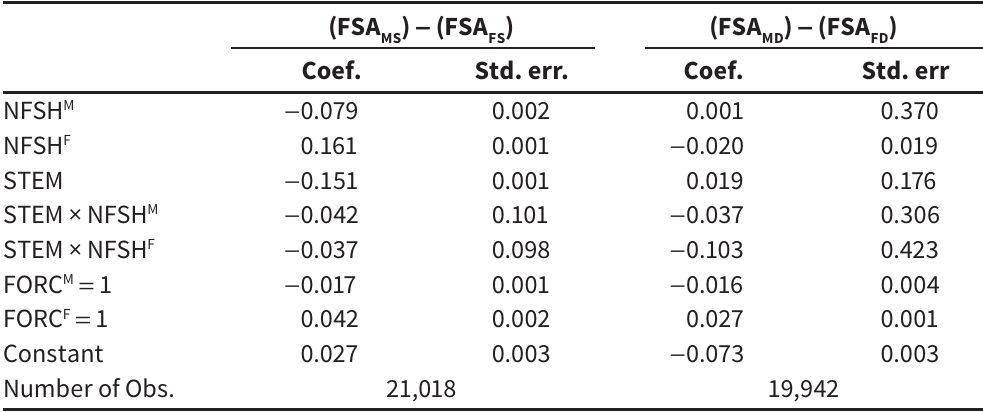
Within-family specification for STEM parents with 41 major CIP codes (FSA ) − (FSA ) MS FS Coef. Std. err. Coef. Std.